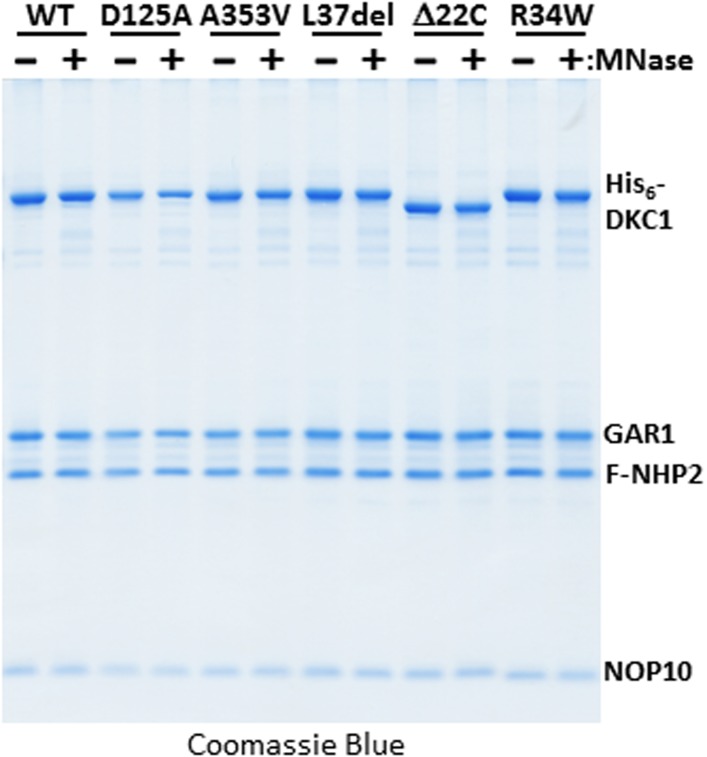
Micrococcal nuclease (MNase)-treated recombinant DKC1 complexes remain structurally intact.Recombinant wild-type (WT) and various mutant DKC1 complexes are mock treated (−) or digested extensively with MNase (+), and washed extensively to remove any dissociated RNAs prior to FLAG peptide elution. Eluted protein complexes are analyzed by Coomassie Blue staining.